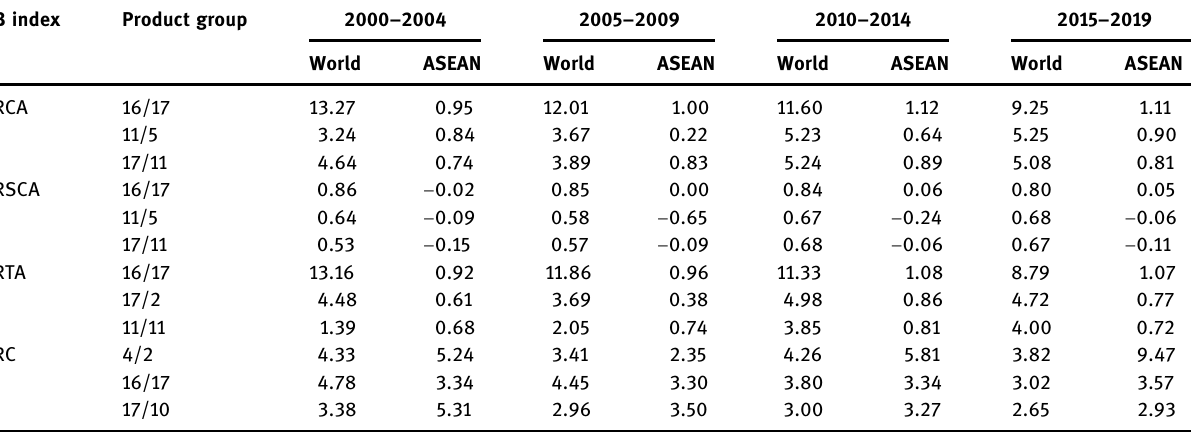
Table 12: The three highest Balassa indices of Thailand at World and ASEAN level, 2000 – 2019